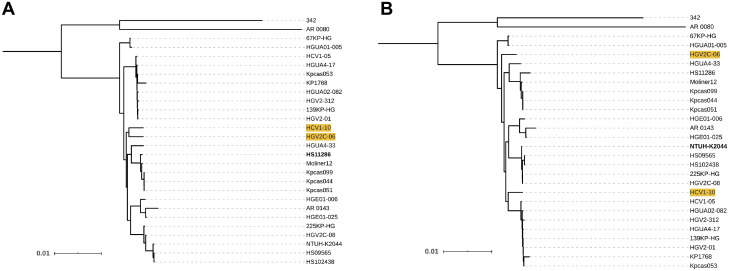
Impact of reference choice on phylogenetic trees of K. pneumoniae.ML trees included the selected reference sequences from K. pneumoniae and the consensus sequences obtained from mappings against strains (A) HS11286 and (B) NTUH-K2044. Isolates HGV2C-06 and HCV1-10 (yellow) changed their placement depending on reference choice.